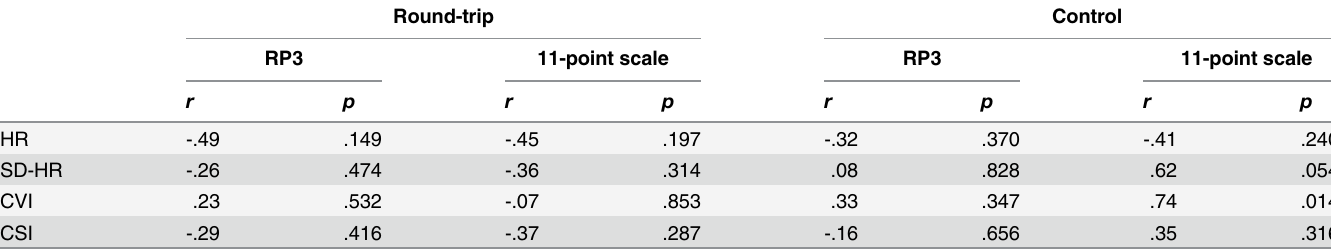
Table 1. Correlation coefficients between ANS and time perception for the round-trip group and the control group.